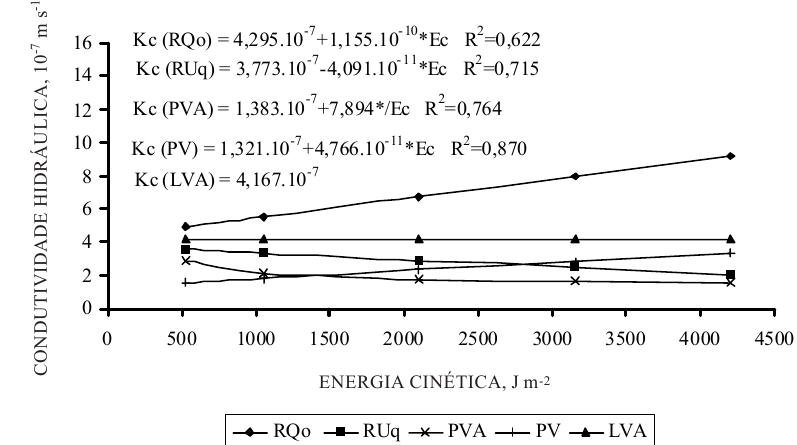
Figura 4. Condutividade hidráulica da crosta (Kc), considerando a energia cinética aplicada (Ec) e a classe de solo (* significativo a 5 % pelo teste t). Sendo: PV = Argissolo Vermelho; PVA = Argissolo Vermelho-Amarelo; LVA = Latossolo Vermelho-Amarelo; RUq = Neossolo Flúvico; e RQo = Neossolo